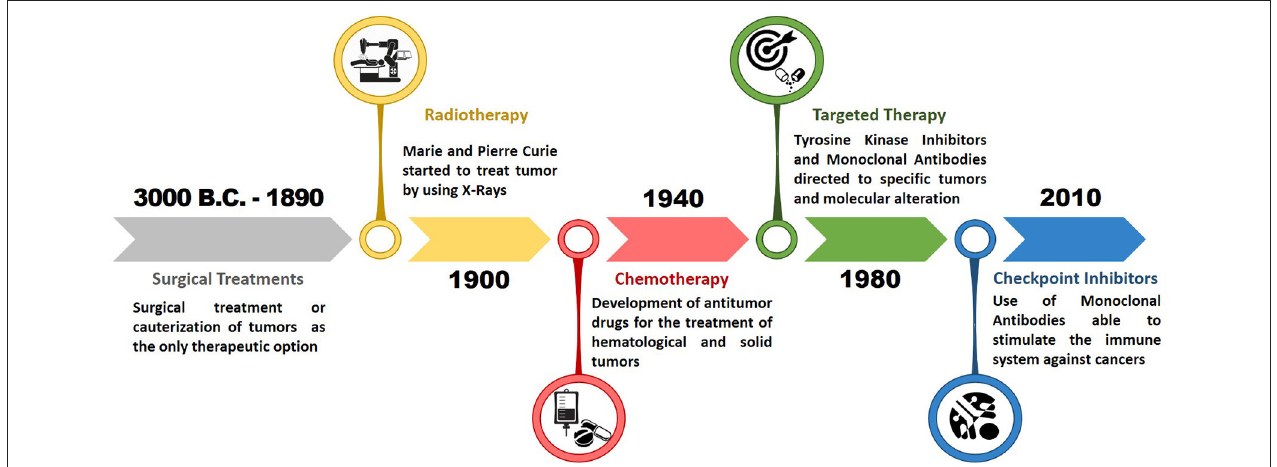
FIGURE 2 | Timeline of epochal turning points in modern oncology. After the development of radiotherapy in the early 1900, the modern oncology began with the discovery of the first chemotherapeutic drugs around 1940. Subsequently a breakthrough in the field of medical oncology occurred with the development of targeted therapy in 1980, which determined an improvement in the effectiveness of cancer treatments. The last epochal turn took place in 2010 with the introduction of immune checkpoints inhibitors for the treatment of advanced and metastatic